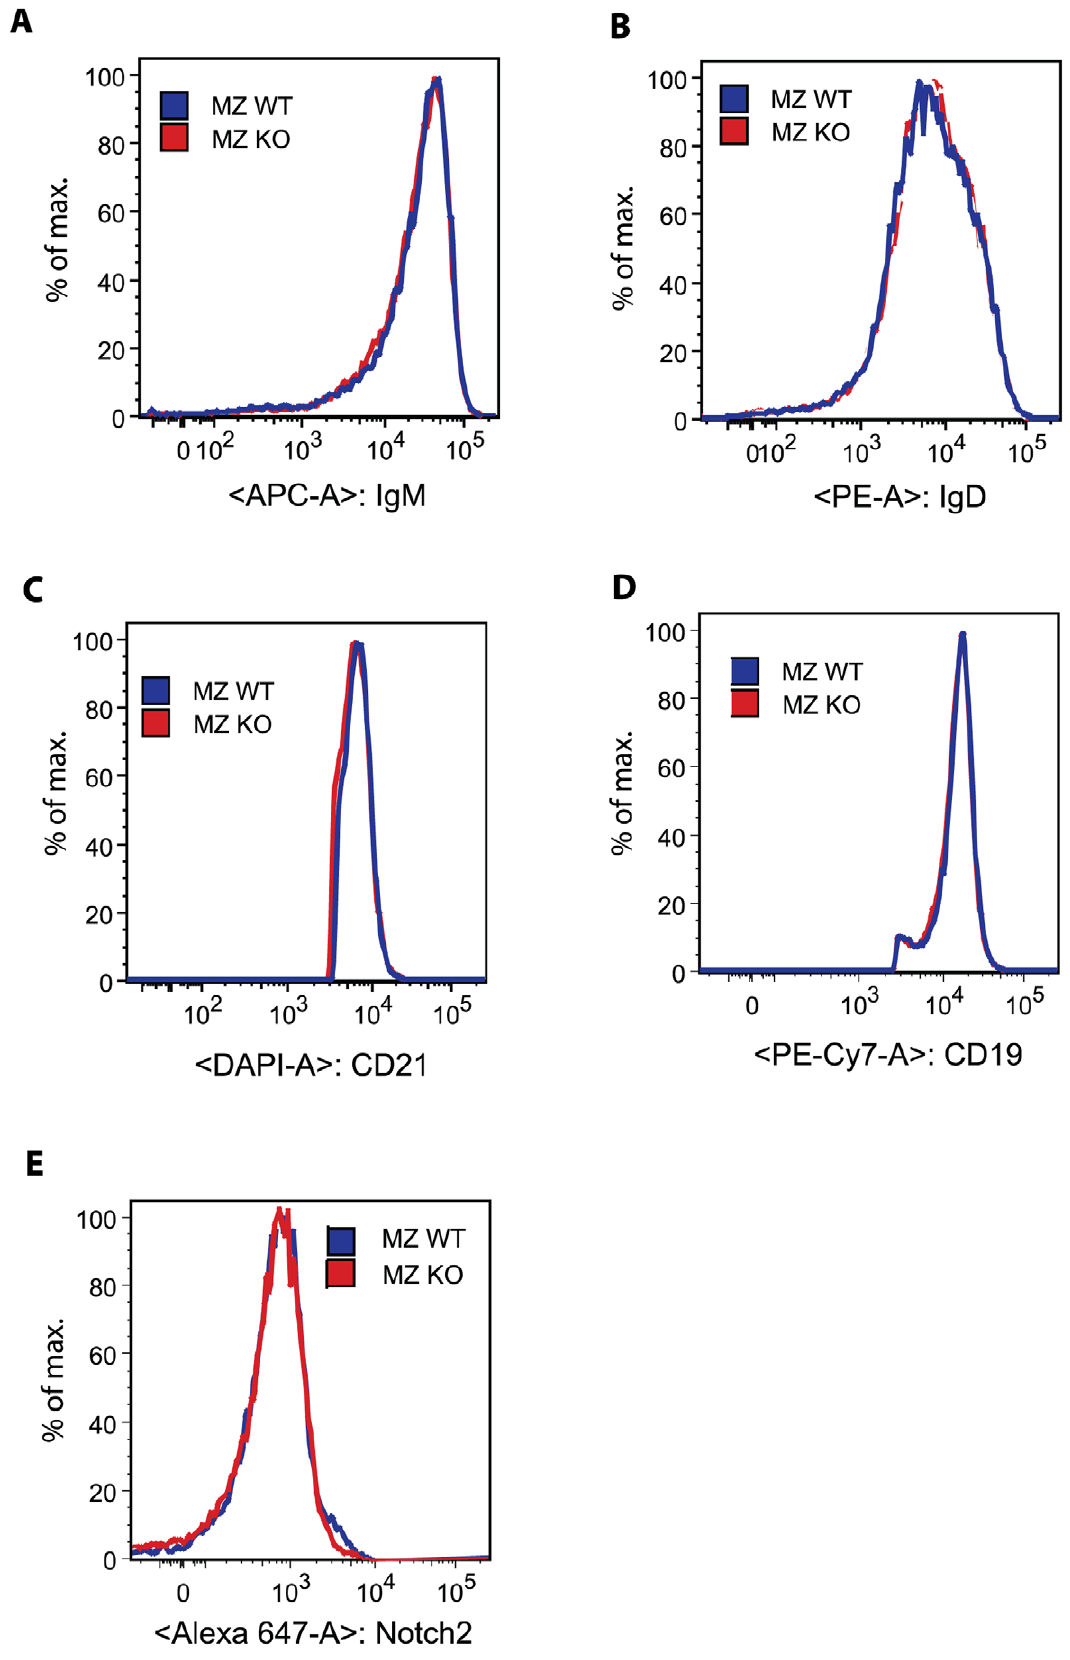
Figure 7. Normal levels of cell surface receptors in Eps15-KO MZ B cells. Representative histograms from MZ B cells from 4-month-old Eps15-WT (blue trace) and Eps15-KO (red trace) mice stained for IgM-APC ( A ), IgD-PE ( B ), CD21-DAPI ( C ), CD19-PE-CY7 ( D ) and Notch2 ( E ). doi:10.1371/journal.pone.0050818.g007 PLOS ONE |